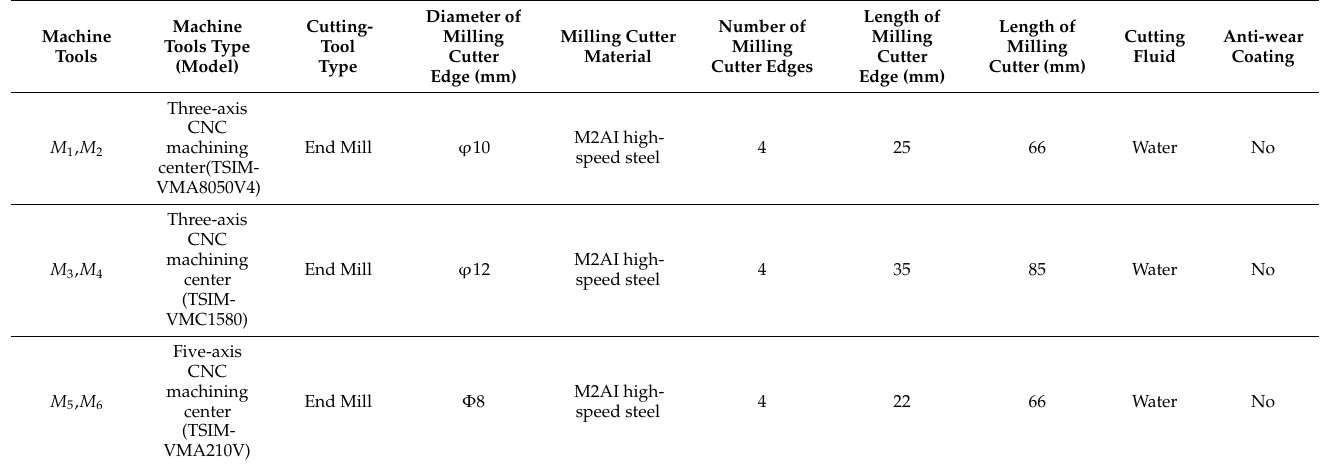
Figure 15. The tool cutting path. Table 2. Basic parameters of experimental devices.